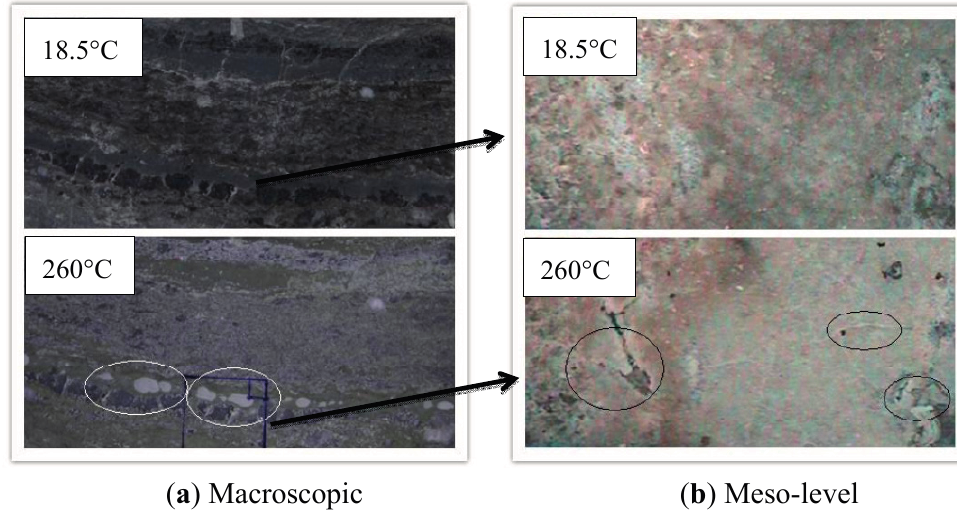
Figure 4. Thermal damage cracks of gypsum under high